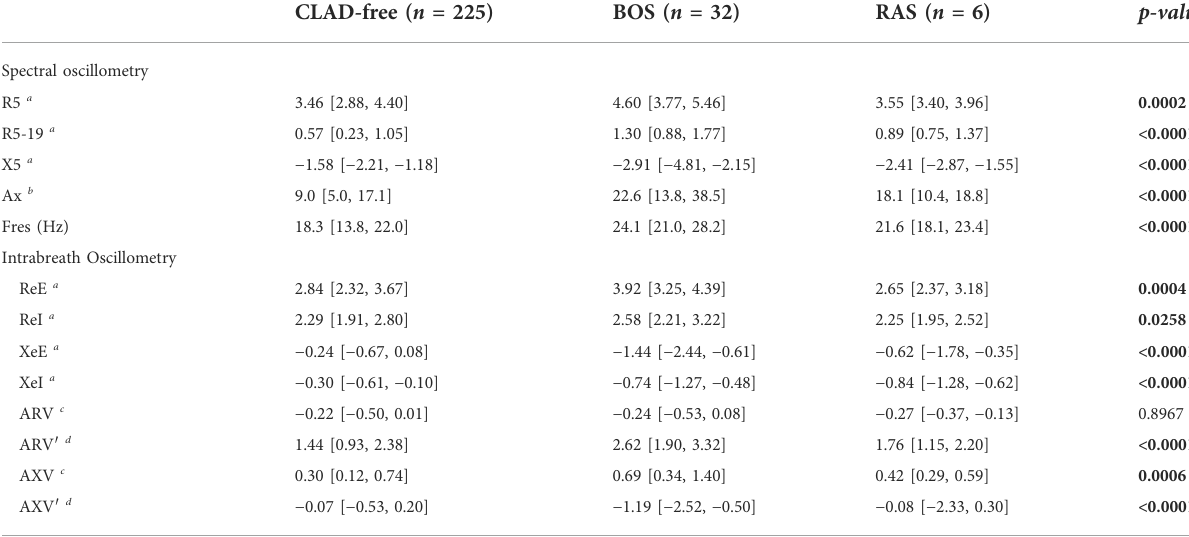
TABLE 2 Comparison of spectral and intrabreath oscillometry parameters between CLAD-free, BOS, and RAS. CLAD-free ( n =